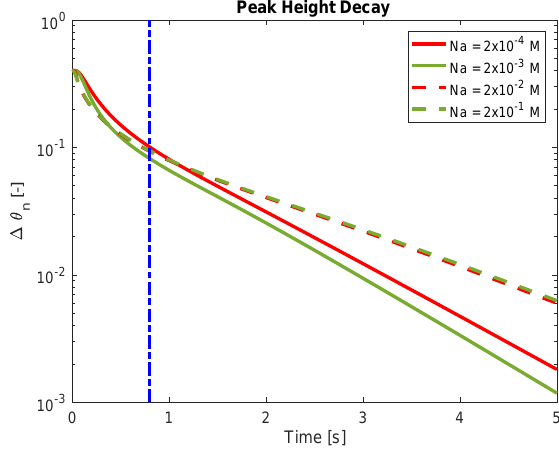
Figure 3. Decay of maximum network volume fraction to steady state for several concentrations of external sodium. Vertical dash-dot line indicates (roughly) the transition from early-time expansion behavior to long-time exponential